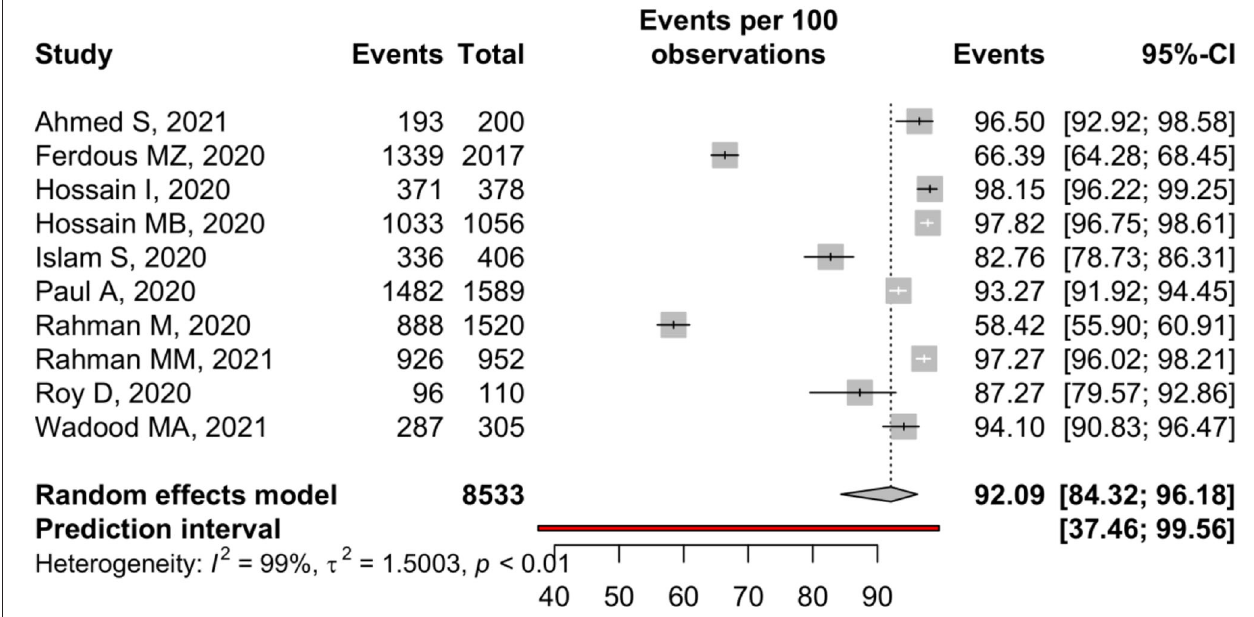
FIGURE 3 | Knowledge about COVID-19 transmission among Bangladeshi residents.